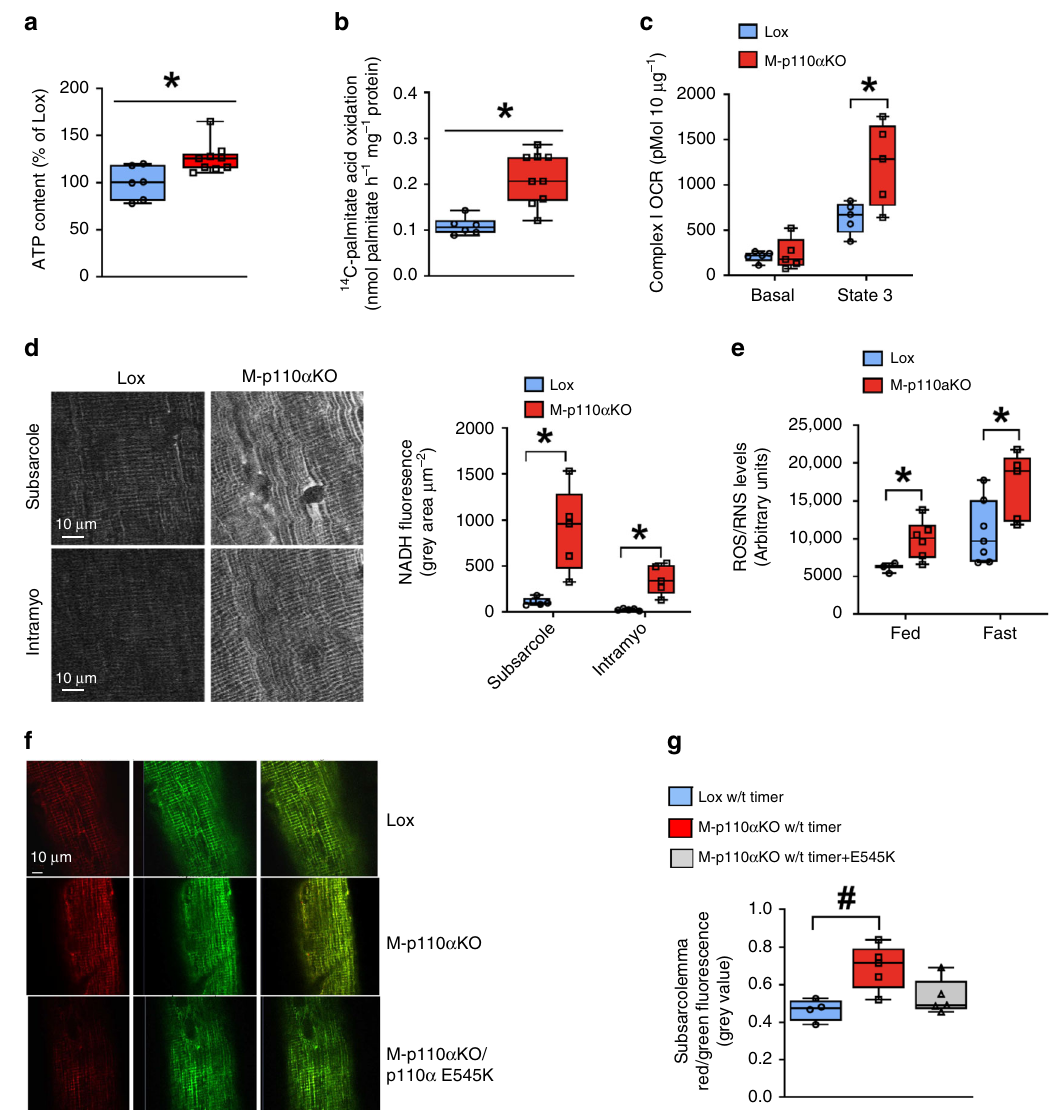
Fig. 5 Increased mitochondrial oxidative capacity in skeletal muscle of M-p110 α KO. a ATP content in quadriceps muscles of M-p110 α KO and control mice in fed state (ctrl, n = 8; KO, n = 9). b Fatty acid oxidation was determined by measuring 14 CO 2 production in the mitochondria isolated from hindlimb of overnight fasted mice using 14 C-palmitate acid as a substrate (ctrl, n = 7; KO, n = 9). c Basal and ADP-dependent (State 3) respiratory rates of the isolated mitochondria from hindlimb of fed M-p110 α KO and control mice were measured using a Seahorse X24 Flux Analyzer in the presence of a Complex I substrate (pyruvate/malate) (ctrl, n = 5; KO, n = 6). d Intravital multiphoton images of mitochondria-speci fi c NADH auto fl uorescence in quadriceps muscles of M-p110 α KO and control mice after overnight fasting (scale bar = 10 μ m). e Levels of total free radicals composed of reactive oxygen species (ROS) and reactive nitrogen species (RNS) measured in gastrocnemius muscles of M-p110 α KO and control mice (ctrl, n = 5; KO, n = 9). f pMitoTimer plasmid was in situ transfected into quadriceps muscle fi bers of living mice using a gene gun delivery approach and visualized 5 days later by the confocal microscope (upper and middle set of images). A different cohort of M-p110 α KO mice was co-transfected with constitutively active mutant p110 α (PIK3CA) E545K into quadriceps of these mice (bottom set of images). g Red/green fl uorescence in subsarcolemmal position of quadriceps muscles in ( f ) ( n = 4 with 3 – 4 fi bers per mouse). All mice were 4- to 5-month old. * P < 0.05 by Student ’ s t test; # P < 0.05 by one-way ANOVA. Subsarco subsarcolemma, intramyo intramyo fi brillar, OCR, oxygen consumption rate, Timer pMitoTimer, E545K p110 α (PIK3CA) E545K. Box plots visualize the fi ve-number summary of the data set (minimum, lower quartile, median, upper quartile, and maximum). The data are mean ±